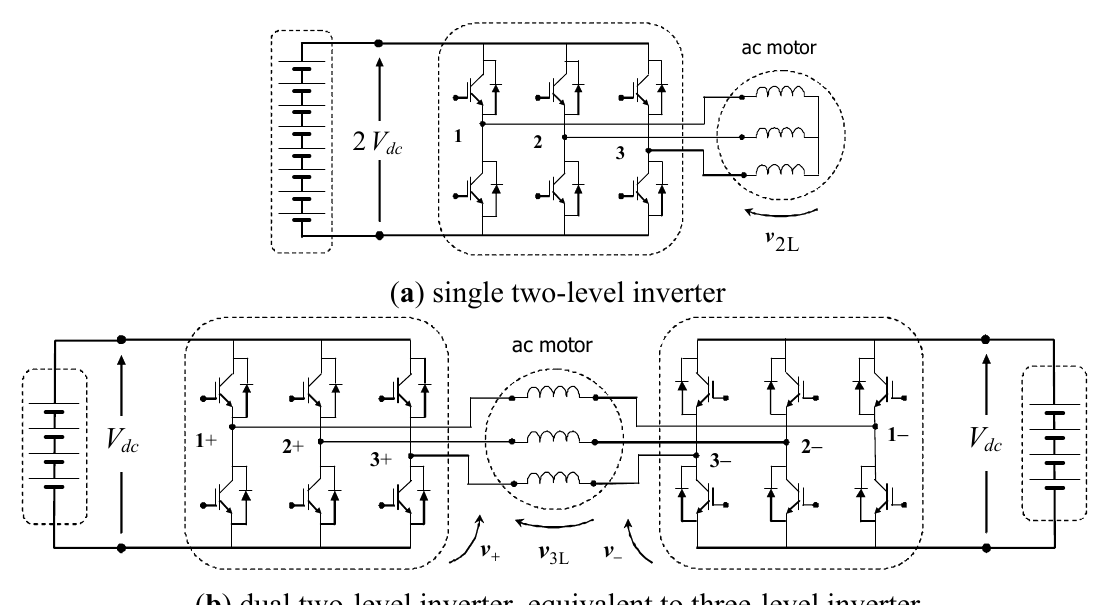
Figure 1. Basic schemes of three-phase motor traction drives. ( a ) Single-2L inverter with double dc voltage; ( b ) dual-2L inverter (3L) with two single dc